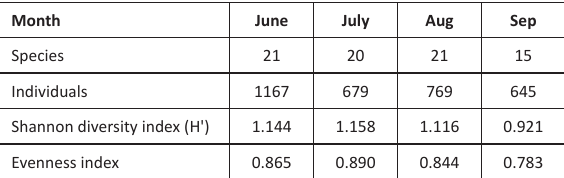
Table 5. Changes in species abundance, Shannon index and evenness index of amphibians in total study period. Month